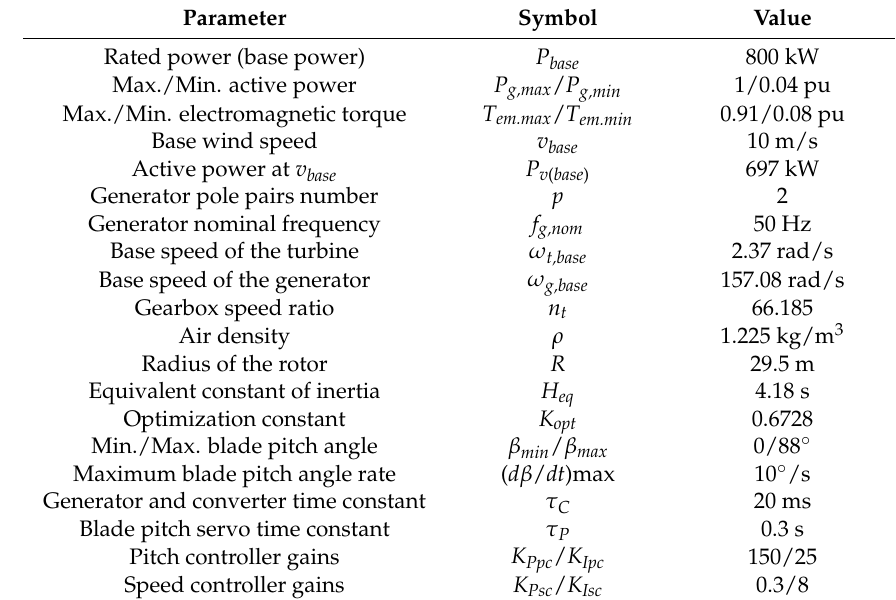
Table A1. Wind turbine